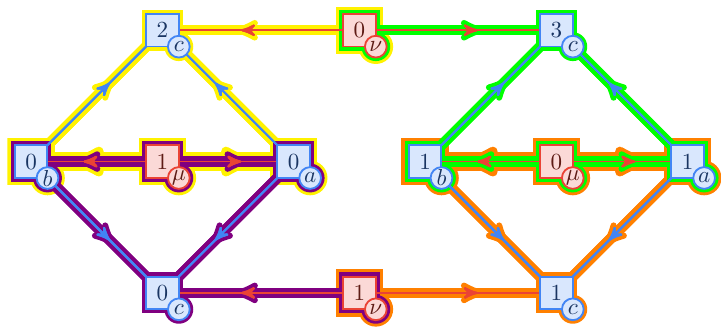
(c) The image of Figure 15b under the permutation 0 µ ↔ 1 µ .